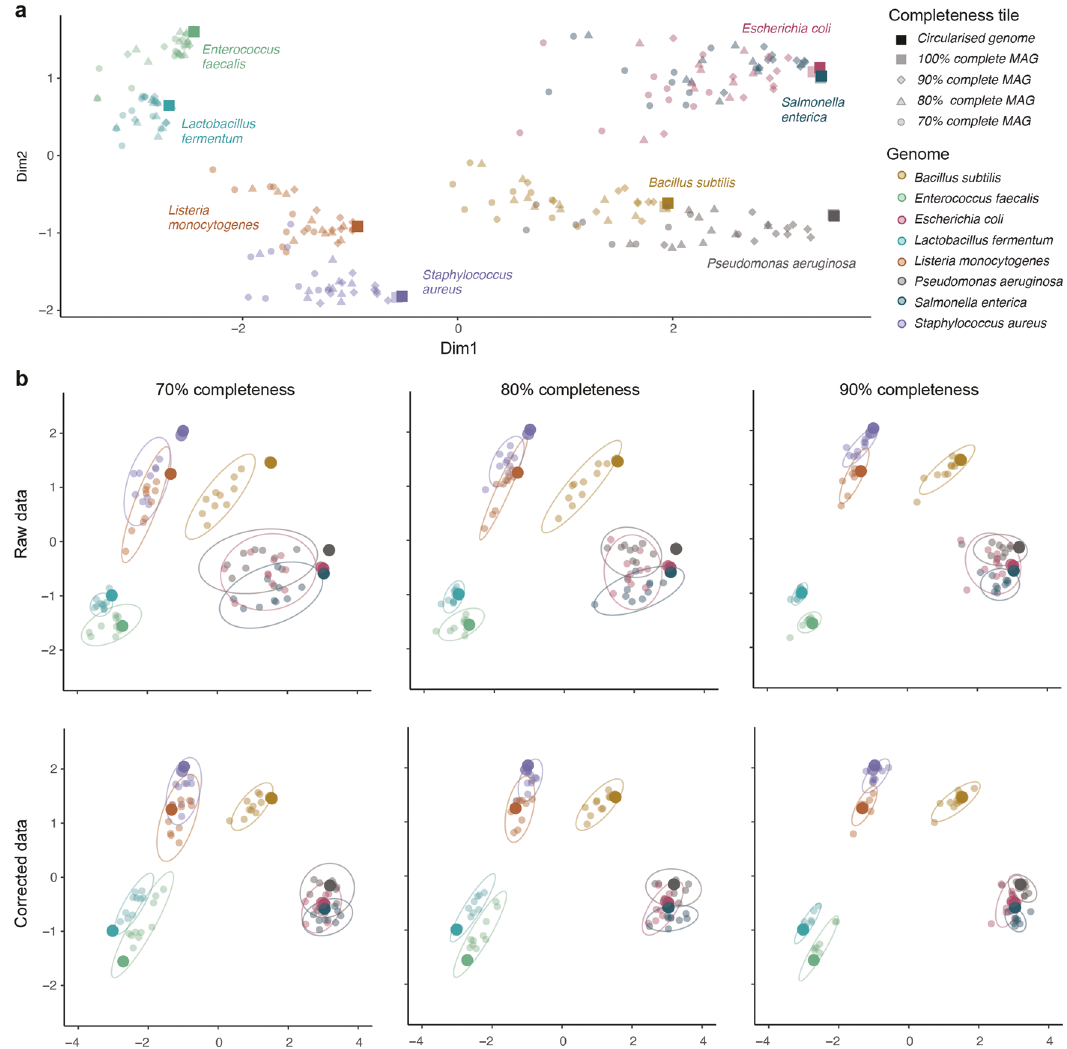
Fig. 3 Principal coordinate analysis (PCoA) ordination of the functional pro fi les of eight complete genomes included in a mock community and their subsampled replicates. a Overall representation of all complete and subsampled genomes. Colours indicate bacterial genomes while shapes show their completeness level. Solid squares are complete circularised genomes while faded squares are their near- complete counterparts reconstructed from metagenomic data. Diamonds, triangles and circles indicate the completeness tile of subsampled MAGs. b Comparison between the raw and corrected functional pro fi les of genomes subsampled at 70%, 80 and 90% completeness. Ellipses show the 95% con fi dence interval of the ten replicates subsampled at each completeness tile. Solid circles refer to 100% genomes, which can be observed that fall more often within the 95% con fi dence interval ellipses of incomplete genomes when functional pro fi les are corrected, indicating corrected fullness values are closer to reality than the original